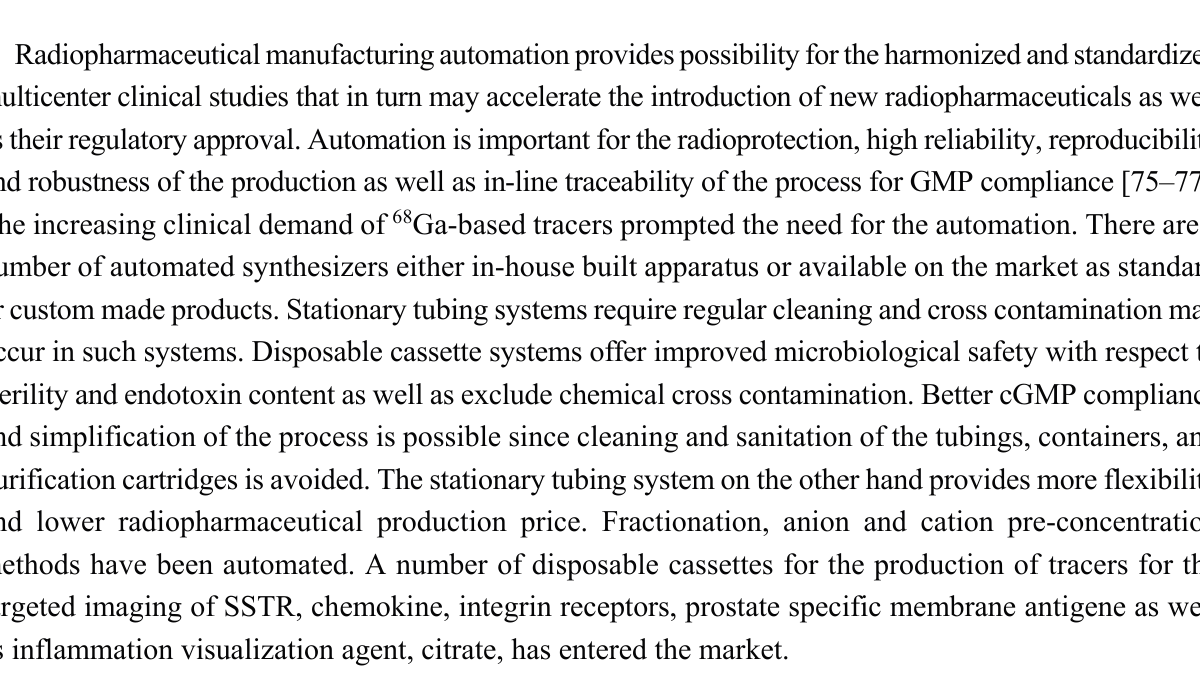
Figure 23. ( Left column ) Typical preparation steps of a 99m Tc-based registered radiopharmaceutical; ( Right column ) Basic steps of an automated manufacturing of a 68 Ga-based